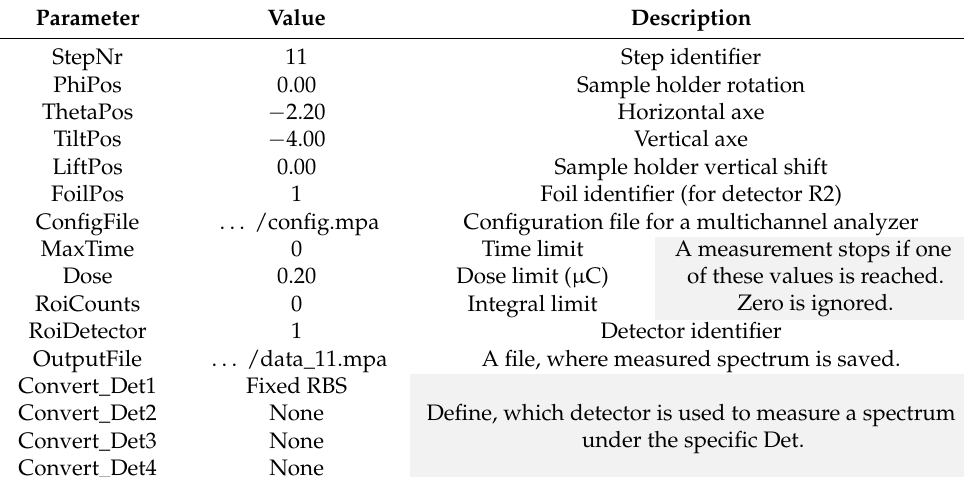
Figure 13. RBS measured spectrum of Si (100), dose 0.5 µC. Table 2. Step #11